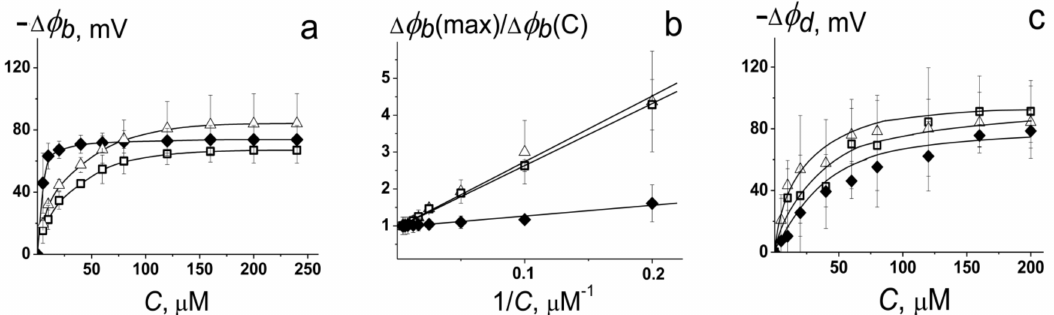
Figure 1. ( a ) The dependence of the changes in the boundary potential of the POPC membranes ( ∆ ϕ b ) on the concentration of sildenafil ( (cid:3) ), vardenafil ( ∆ ), and tadalafil ( (cid:7) ) in the aqueous solution. The bilayer bathed in 0.1 M KCl at pH 7.4 ( V = 50 mV). ( b ) The dependences of ( ∆ ϕ b (max)/ ∆ ϕ b ( C )) on 1/ C in POPC membranes. ( c ) The dependence of the changes in the dipole potential of the POPC membranes ( ∆ ϕ d ) on the concentration of tested PDE-5 inhibitors.